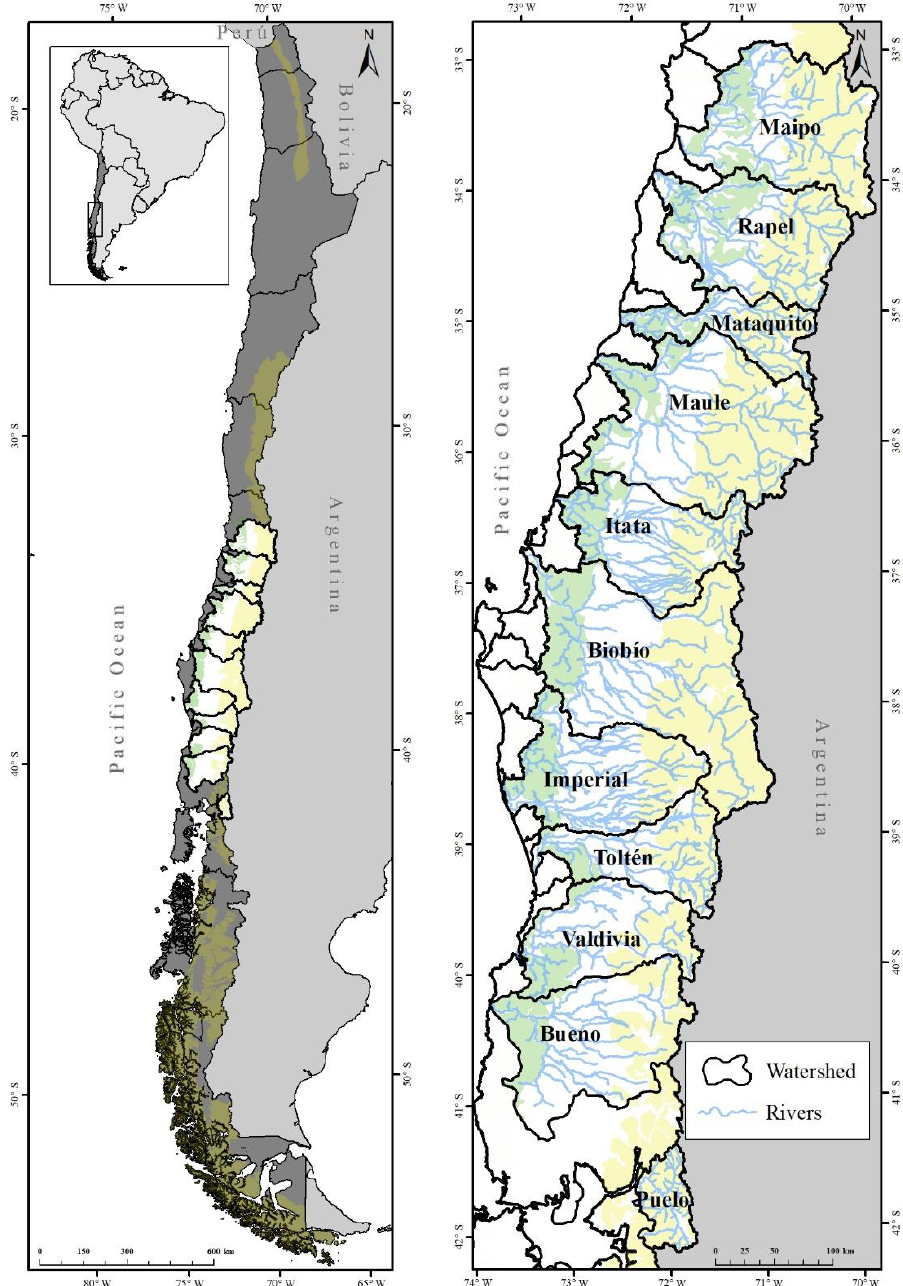
Figure 1. Geographic location of the eleven studied river basins and their river networks assessed in this study. Yellow area represents the Andes Cordillera; white area is the Central Valley; and green area corresponds to the Coastal Cordillera.